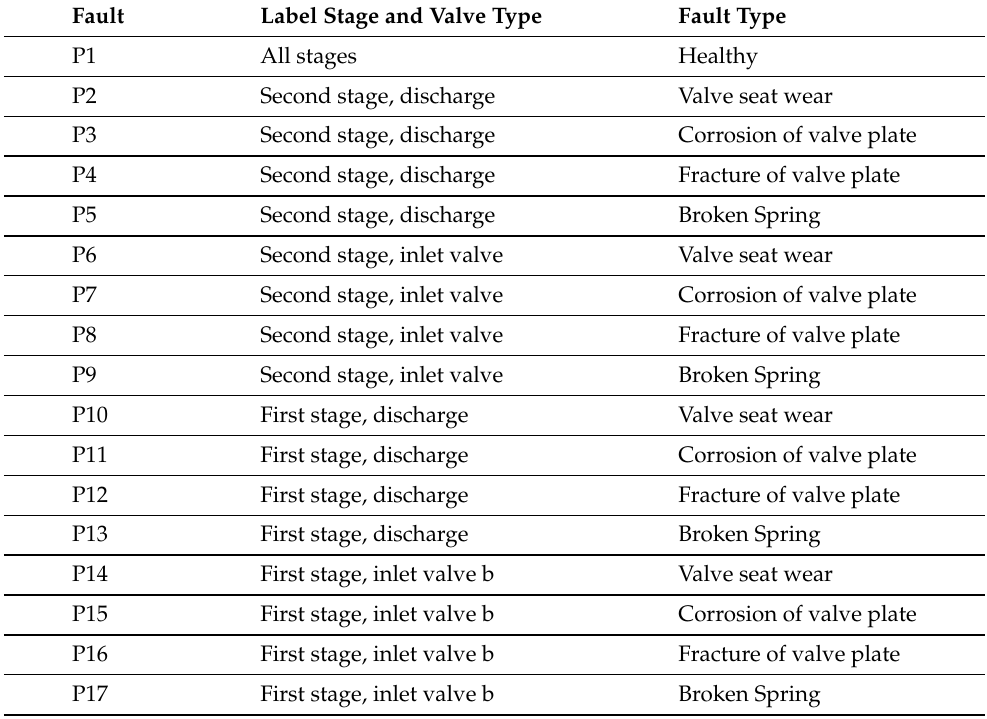
Table 2. Valve faults in the